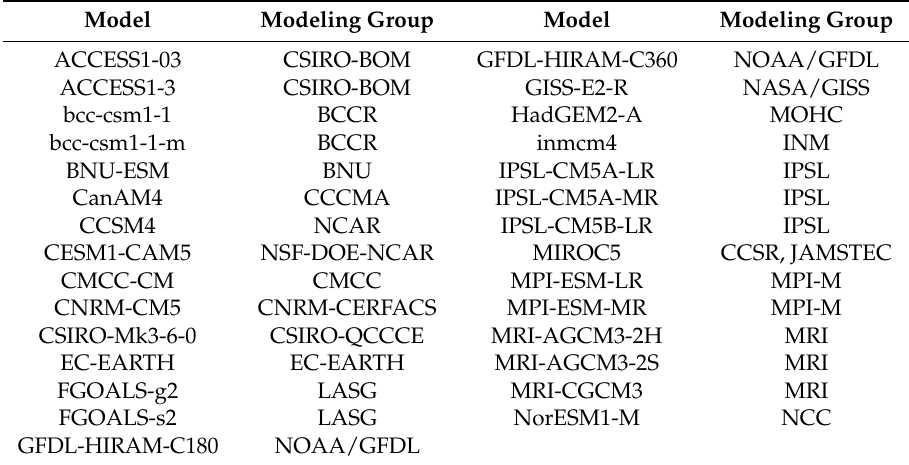
Table 1. The 29 models used in this